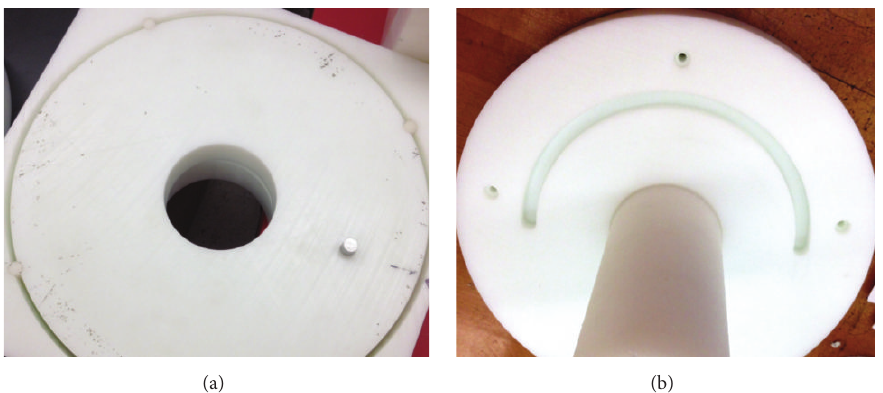
Figure 4: (a) Stationary donut-shaped component that rests on the shipping drum; (b) bottom of the RIC that rests and slides on the component shown left.